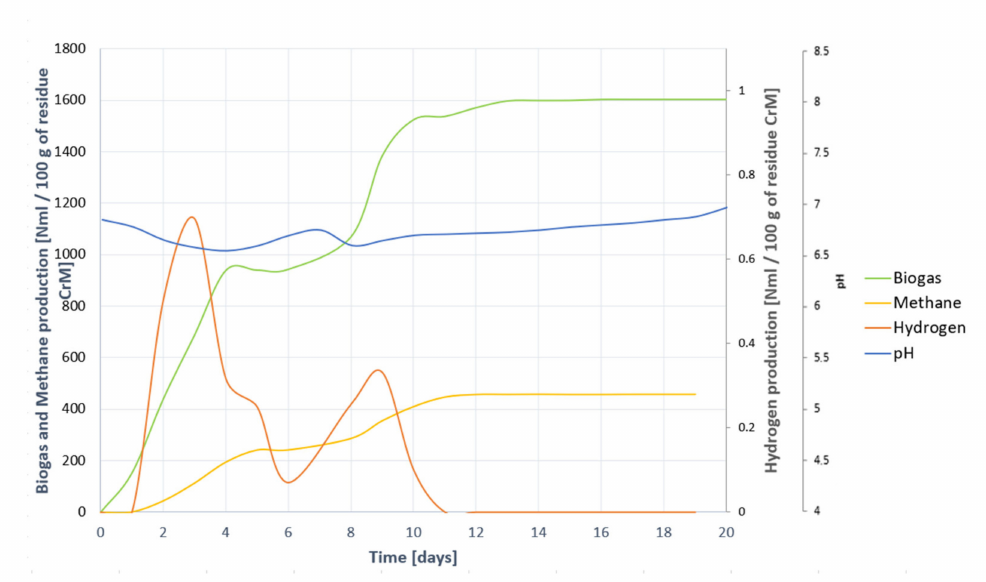
Figure 6. Evolution of the digestion process of residue CrM. Comparison of the generation of biogas, methane and hydrogen together with the evolution of